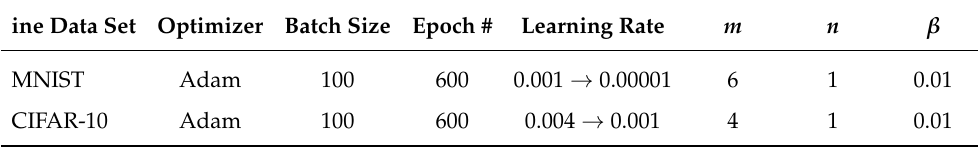
Table 3. Learned hyperparameter values for the classic neural network